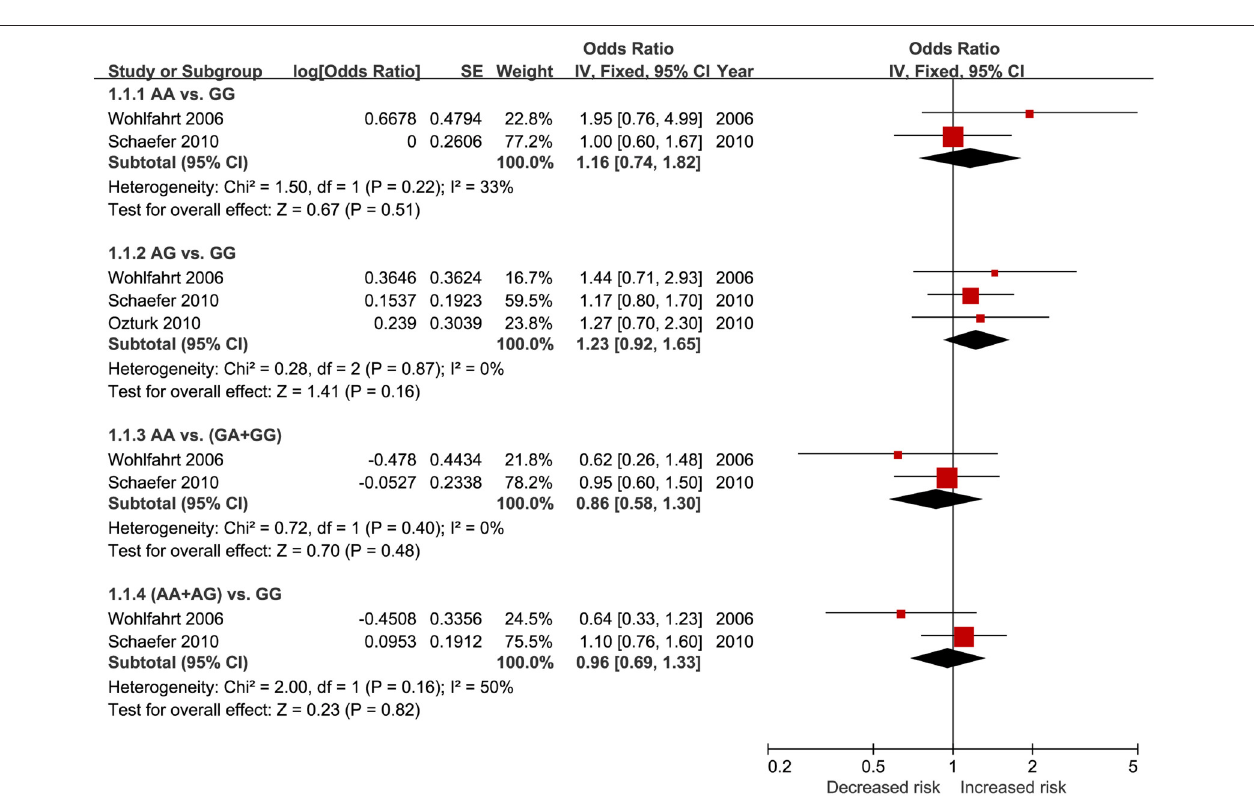
FIGURE 4 | Forest plot of adjusted data in all five genetic models. CI, Confidence